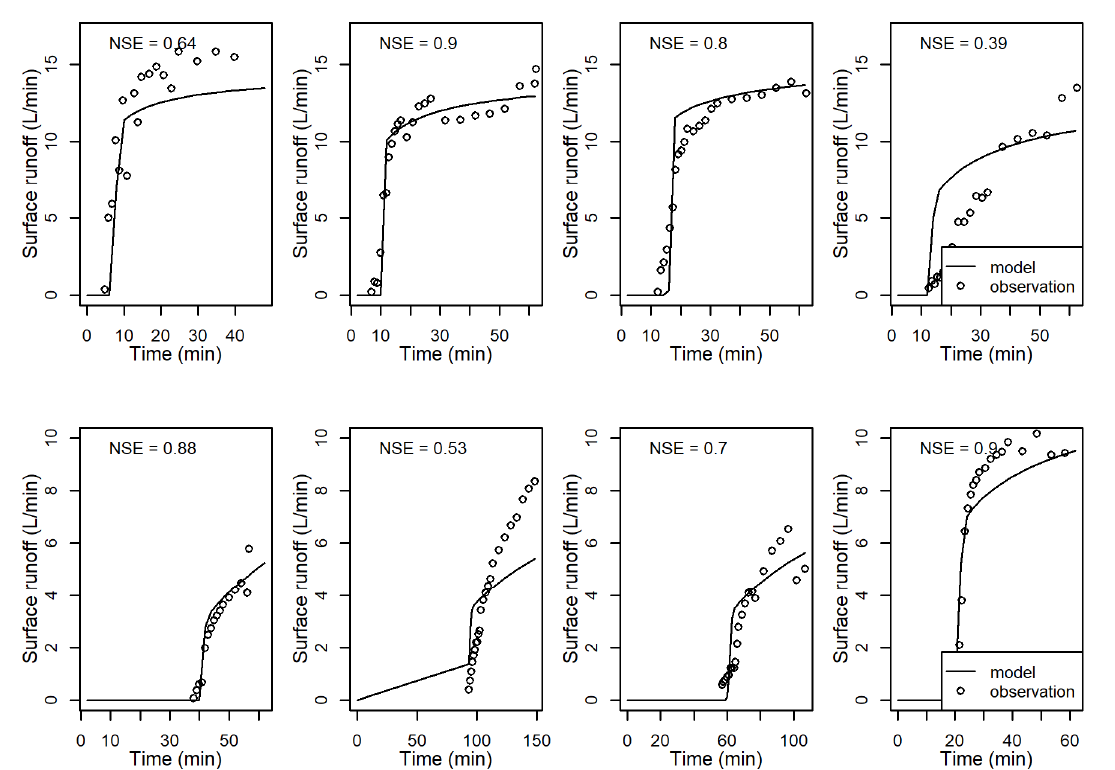
Figure 4. Results of the calibration procedure. The top row shows the bare soil results. The bottom row shows the results for plots with a vegetated soil surface. Table 2. The mean and standard deviation of calibrated parameters for bare soil and for a vegetated surface.